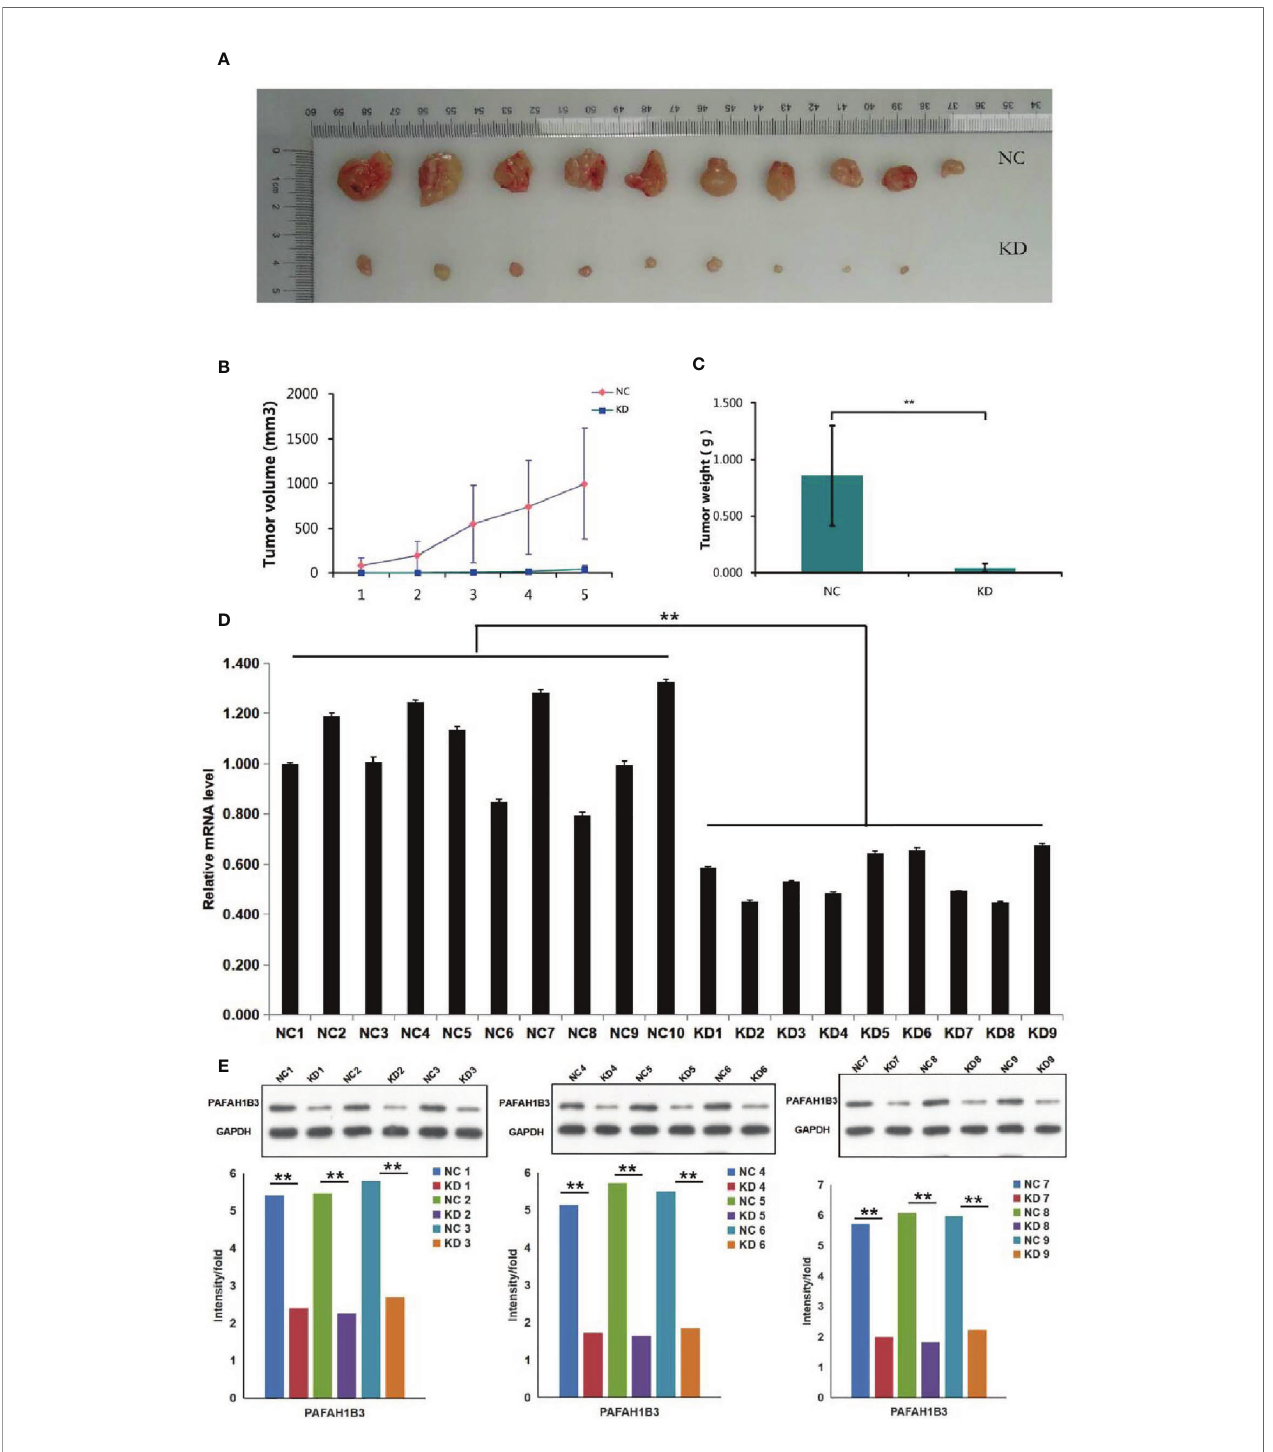
FIGURE 5 | Effects of PAFAH1B3 knockdown on tumor growth in vivo . (A) The tumor volume was obviously decreased in PAFAH1B3 knockdown group. (B) The difference of the tumor volume was shown clearly between PAFAH1B3 knockdown group and negative control after 5 measurements. (C) The tumor weight was signi fi cantly declined in PAFAH1B3 knockdown group (** P < 0.01). (D) The expression of PAFAH1B3 mRNA level was signi fi cantly declined in PAFAH1B3 knockdown group (** P < 0.01). (E) The expression level of PAFAH1B3 was detected by Western blotting and signi fi cantly declined in PAFAH1B3 knockdown group (** P < 0.01). NC, negative control KD;